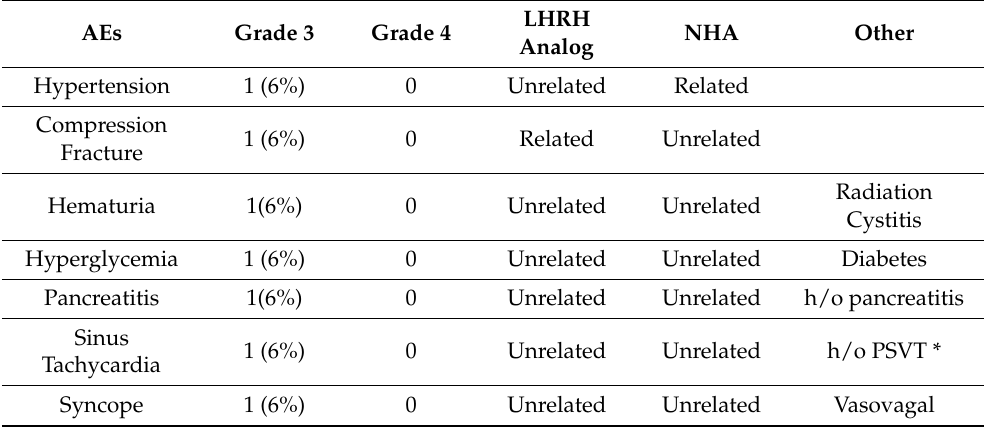
* PSVT, paroxysmal supraventricular